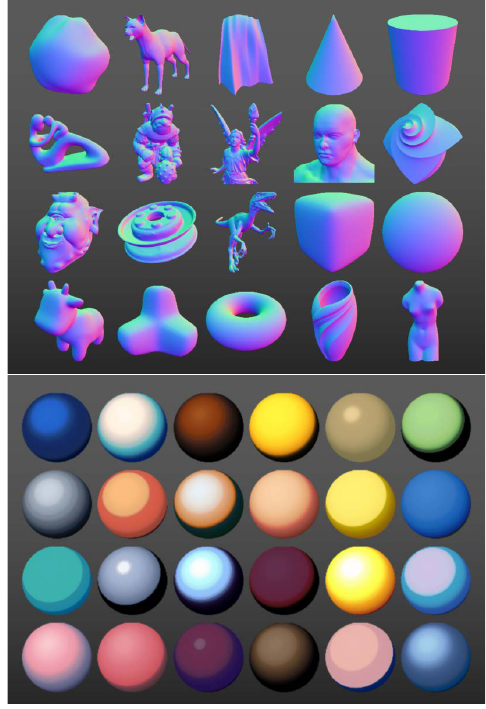
Fig. 8 20 ground-truth 3D shapes and 24 color maps in our datasets.